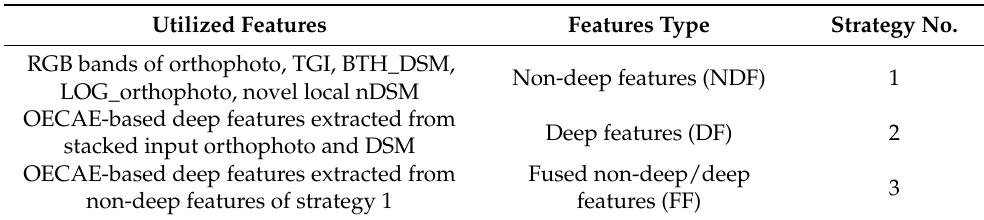
Table 3. Applied features in each